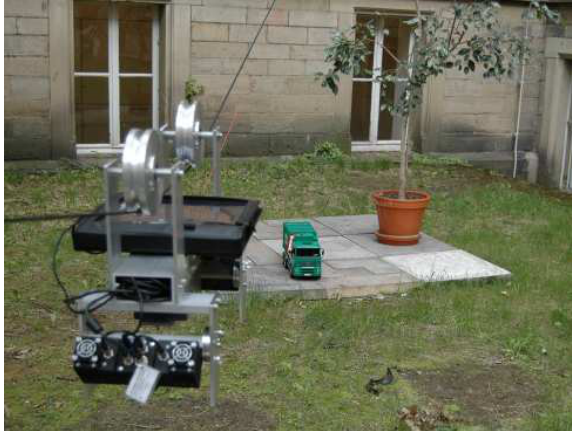
Figure 6. Experimental device while recording with scene content.